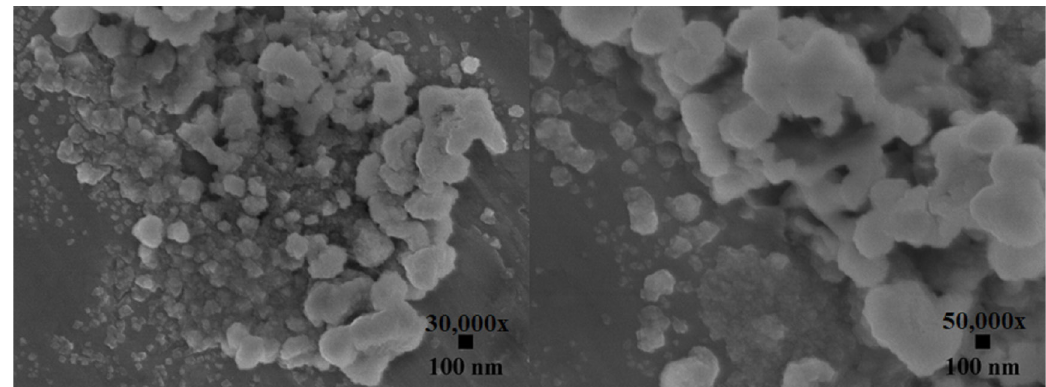
Figure 3. Nanostructures over the surface of anodized titanium with HCl at 12 V with a concentration of 3M in 10